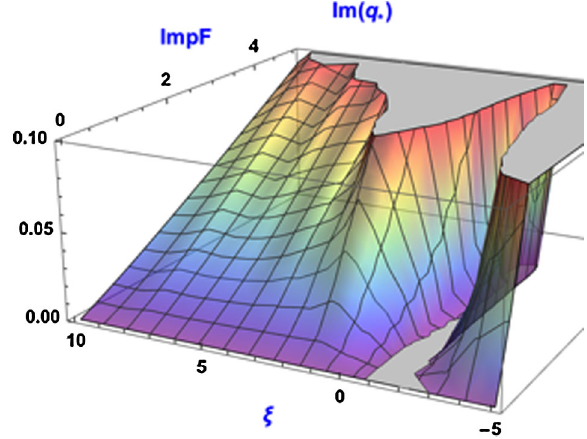
FIG. 17. Same for resistive g ¼ 1 .